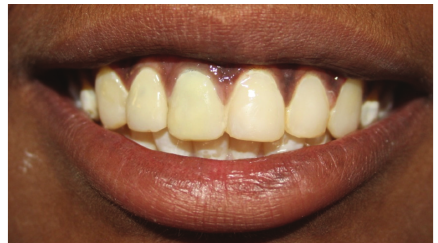
Figure 12: Six-month recall.